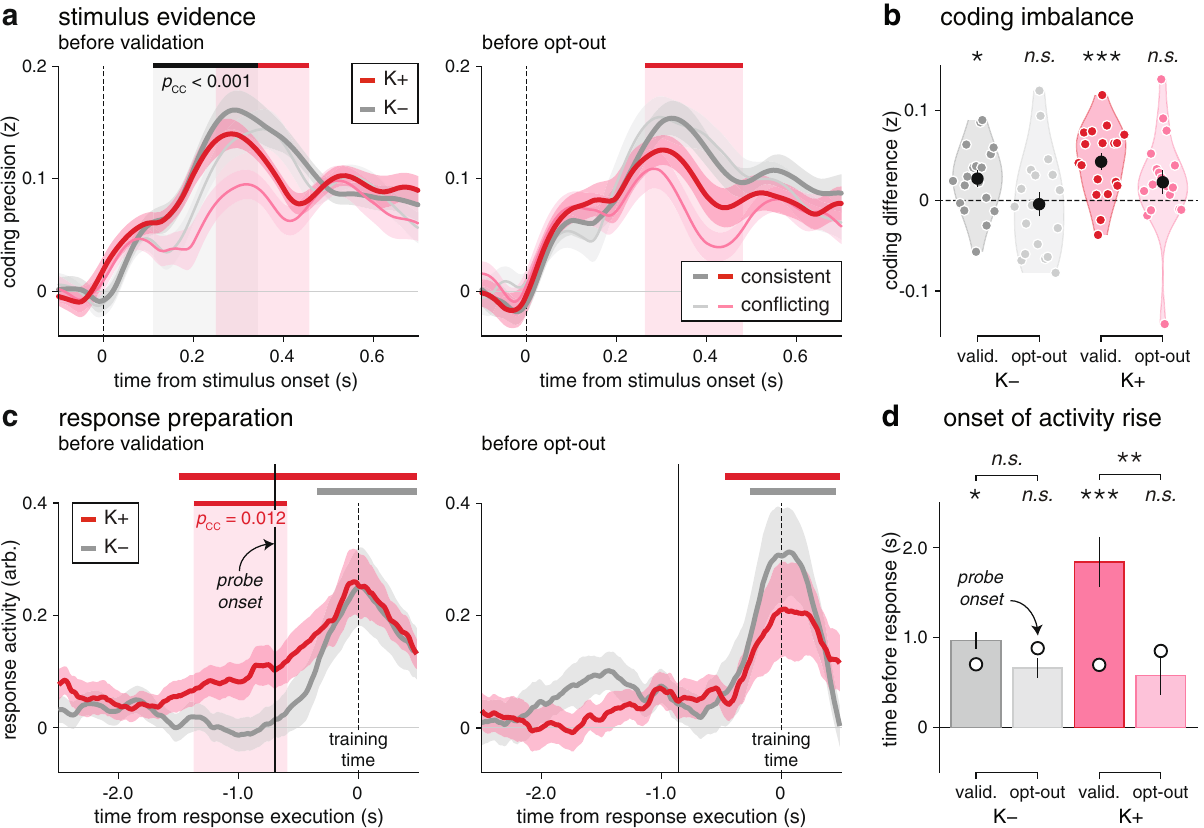
Fig. 8 Relation between premature commitments and decision uncertainty. a Relation between coding unbalance and decision validation vs. opt-out. Coding precision of stimulus evidence for consistent (thick lines) and con fl icting stimuli (thin lines), in trials ending with decision validation (left) or opt-out (right). Lines and shaded error bars indicate group-level means ± s.e.m. ( N = 18 participants). The gray-shaded area indicates the signi fi cant effect of decision consistency, whereas the red-shaded areas indicate the signi fi cant effects of ketamine (two-sided t tests corrected for multiple comparisons across time). Coding imbalance is more pronounced in trials ending with decision validation. b Non-interacting relations of ketamine and decision validation with coding unbalance, averaged in the time window where it is signi fi cant across conditions (115 – 400 ms following stimulus onset). c Relation between response preparation and decision validation vs. opt-out. Response activity in the last 2.5 s preceding response execution, in trials ending with decision validation (left) or opt-out (right). Premature response preparation (signi fi cant response activity before the “ go ” signal) is only detected under ketamine in trials ending with decision validation (two-sided t tests corrected for multiple comparisons across time). d Estimated onsets of response activity rise. Response activity rises well before the “ go ” signal under ketamine in trials ending with decision validation. Bars and error bars indicated jackknifed group- level means ± s.e.m. ( N = 18 participants). One star indicates a signi fi cant effect at p < 0.05, two stars at p < 0.01, three stars at p < 0.001, n.s. a non- signi fi cant effect ( N = 18 participants, uncorrected two-sided t tests with jackknife adjustment for onsets of response activity rise). Source data are provided as a Source Data fi scale across trials in the experiment. To assess whether the different effects of ketamine are sustained across time, we computed them separately for the fi rst and second halves of the experiment. All reported effects were sustained across time. In terms of behavior, the effect of ketamine on opt-out rate (Fig. 1d) was sustained across the two halves of the experiment (main effect of ketamine: F 1,17 = 18.3, p < 0.001; interaction with time: F 1,17 = 0.4, p = 0.511). Similarly, the effect of ketamine on inference noise (Fig. 3c) was sustained across time in the experiment (main effect of ketamine: F 1,17 = 10.5, p = 0.005; interaction with time: F 1,17 = 0.7, p = 0.428). In the EEG data, the imbalanced coding of evidence (Fig. 5b) observed under ketamine was also sustained across time (main effect of stimulus consistency on coding precision: F 1,17 = 24.8, p < 0.001; interac- tion with time: F 1,17 < 0.1, p = 0.993). Similarly, the premature response preparation activity (Fig. 6b) observed under ketamine